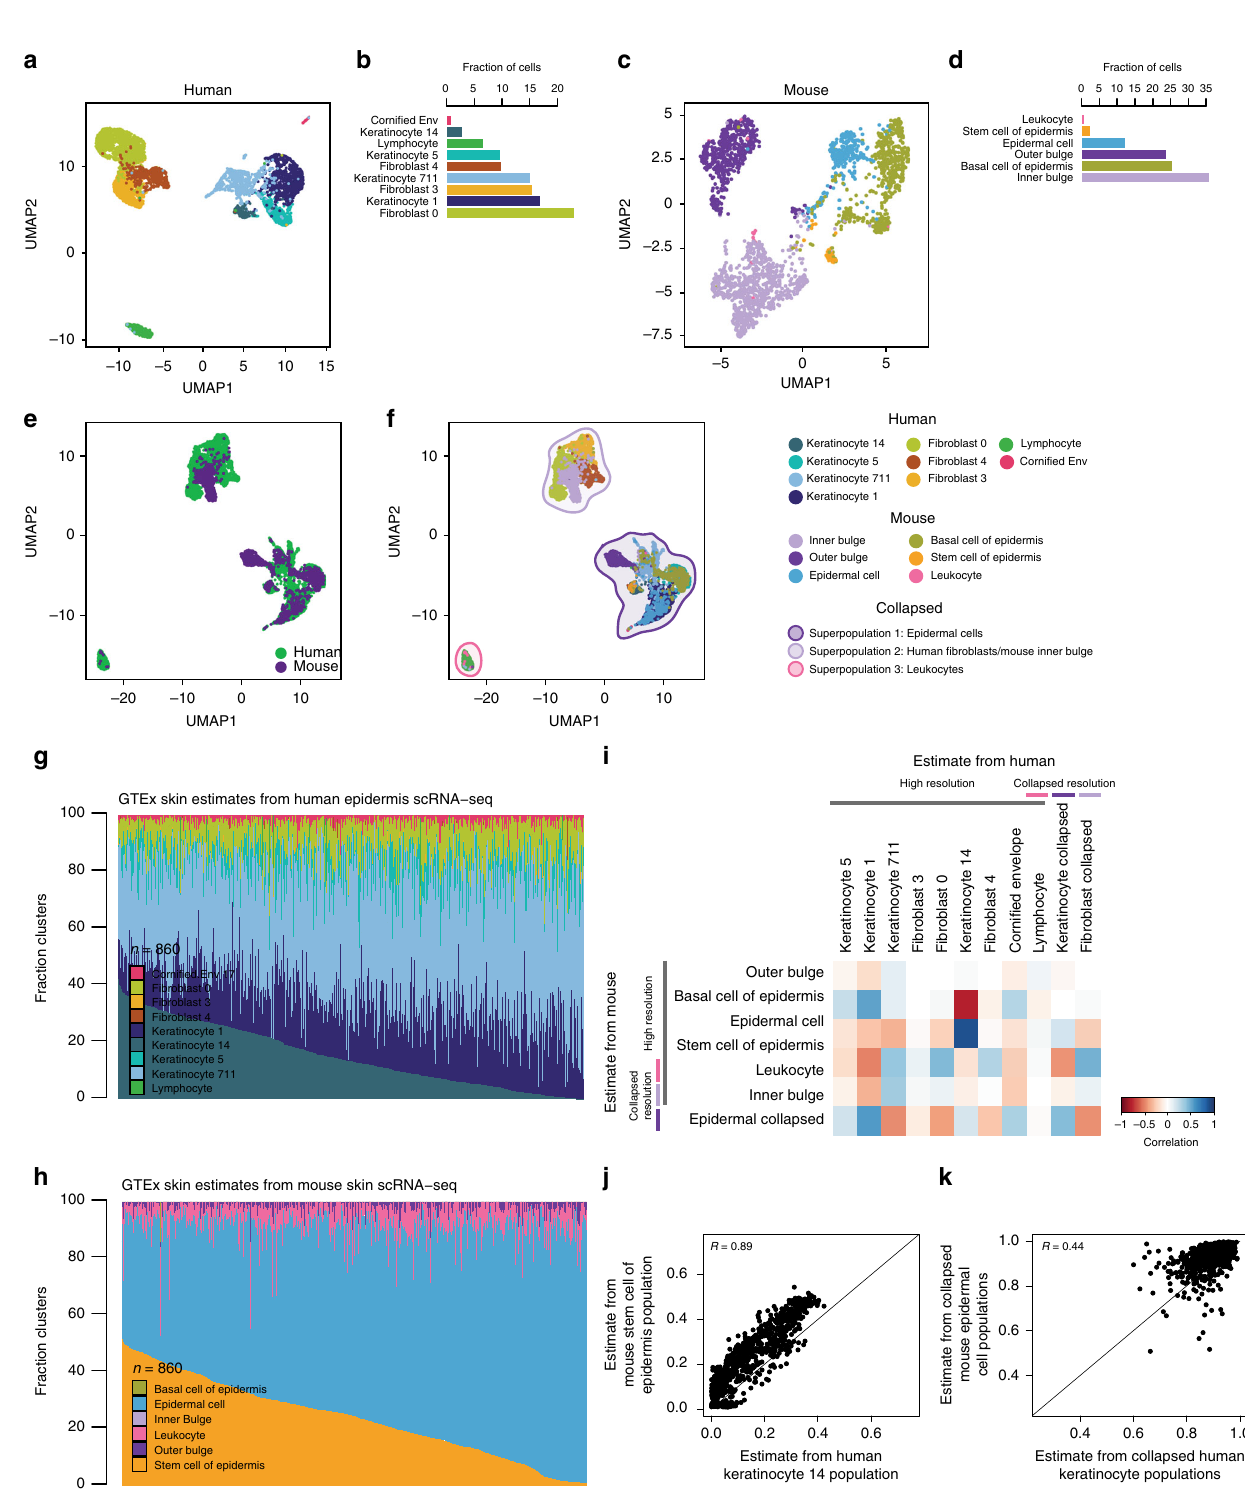
human fi broblasts and mouse inner bulge cells to cluster together, their signature genes distinguish them as different cell types during deconvolution. Third, we examined the similarity of the human cell type (lymphocyte) and mouse cell type (leukocyte) in superpopulation 3 (Fig. 3f; pink shading). Similar to the liver estimates, mouse and human leukocyte estimates were not correlated (Fig. 3i, Supplementary Data 2B), likely due to known species differences in immune cells. As we observed in liver, we con fi rmed that technical and biological differences in fl uence